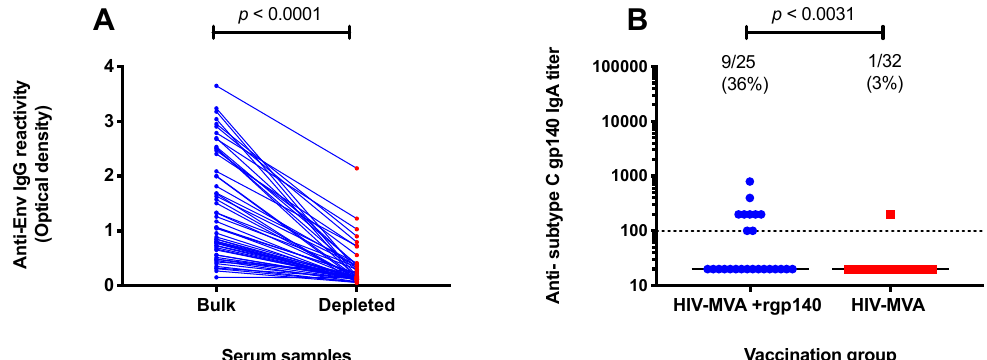
Figure 6. IgA antibodies to subtype C (CN54) gp140. IgG-depleted serum samples were used to assess